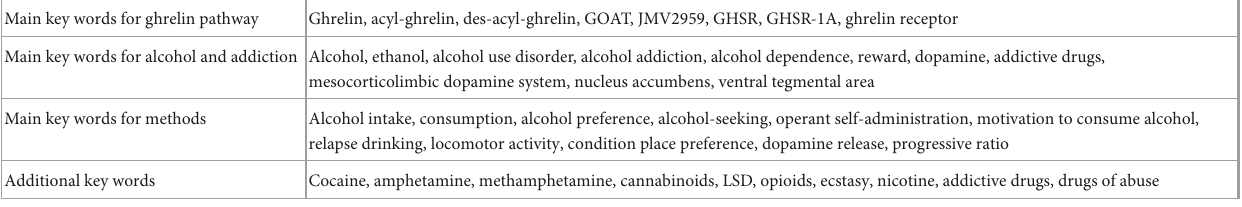
TABLE 1 Main keys words for the selected articles presented in the present